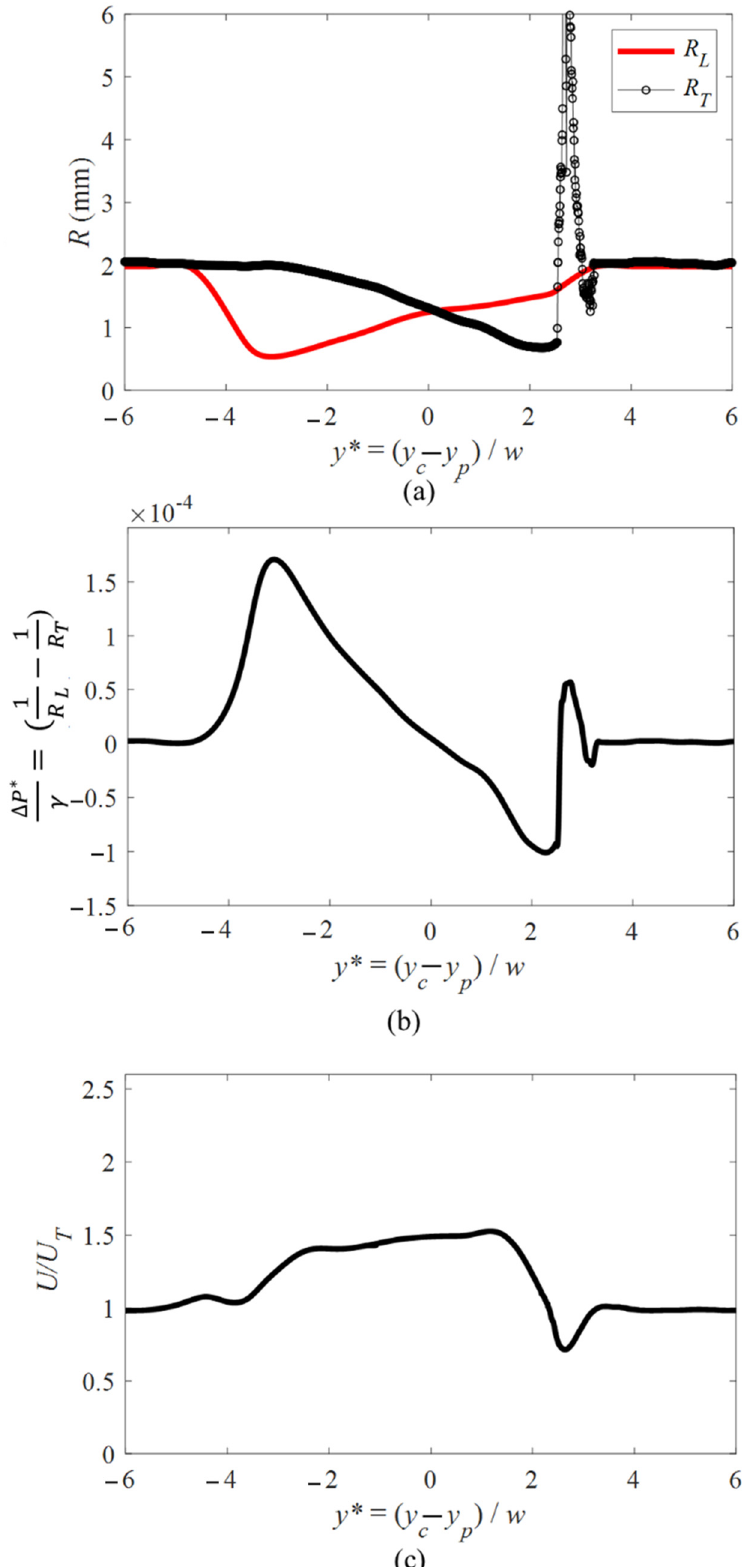
Figure 13. Plots of ( a ) change in the radii of curvature of leading and trailing edge of a bubble, ( b ) pressure along the bubble, and ( c ) velocity of the projected area of a bubble ( R b ∼ 1.95 mm) passing through a sharp pore (Sample images of different conditions are shown in Figure 6IV).